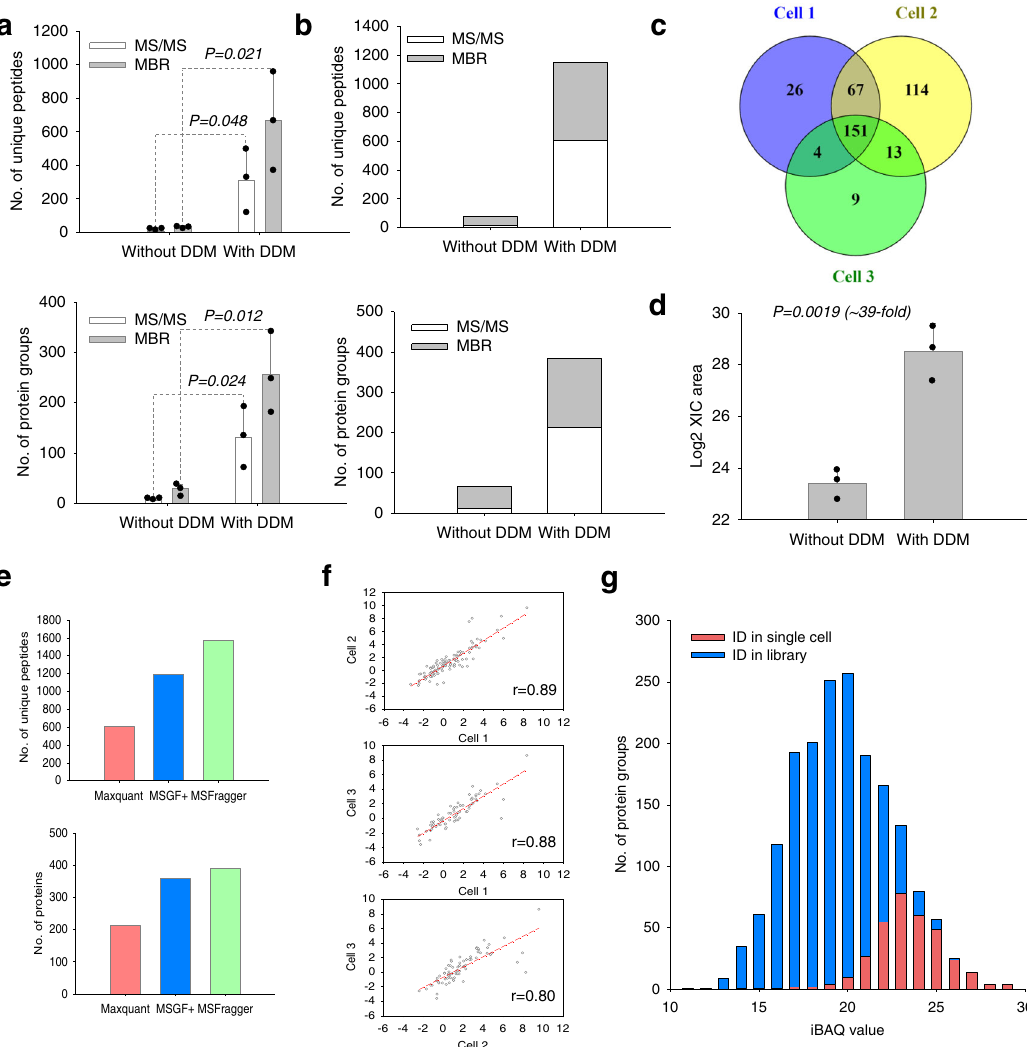
Fig. 3 SOP-MS analysis of single MCF10A cells sorted by FACS. a Number of unique peptides and protein groups identi fi ed by MS/MS only and the combined MS/MS and MBR from single MCF10A cells without and with the addition of 0.015% DDM (three biological replicates per condition; P < 0.05 between without and with DDM). b Total number of unique peptides and protein groups identi fi ed by MS/MS only and the combined MS/MS and MBR across all three biological replicates without and with the addition of 0.015% DDM. c Venn diagram showing the number of protein groups identi fi ed from each of three single MCF10A cells with the addition of 0.015% DDM by the combined MS/MS and MBR. d The summed total XIC peak area for all quanti fi able peptides from single MCF10A cells (three biological replicates per condition; P < 0.05 between without and with DDM). e Total number of unique peptides and protein groups identi fi ed by the MS/MS spectra alone from all three biological replicates using three common search tools (MaxQuant, MSGF + , and MSFragger). f Pairwise correlation of protein LFQ intensities between any two replicates with the Pearson correlation coef fi cient. g Distribution of protein abundance for all proteins identi fi ed from single MCF10A cells and 10 ng MCF10A cell lysate digests. Library was built with 10 ng MCF10A cell lysate